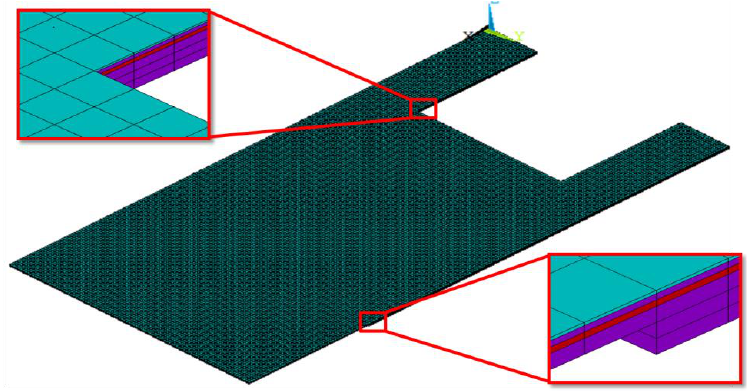
Figure 2. Finite element model of the slotted microcantilever showing the piezoresistor and substrate layout details (inset).